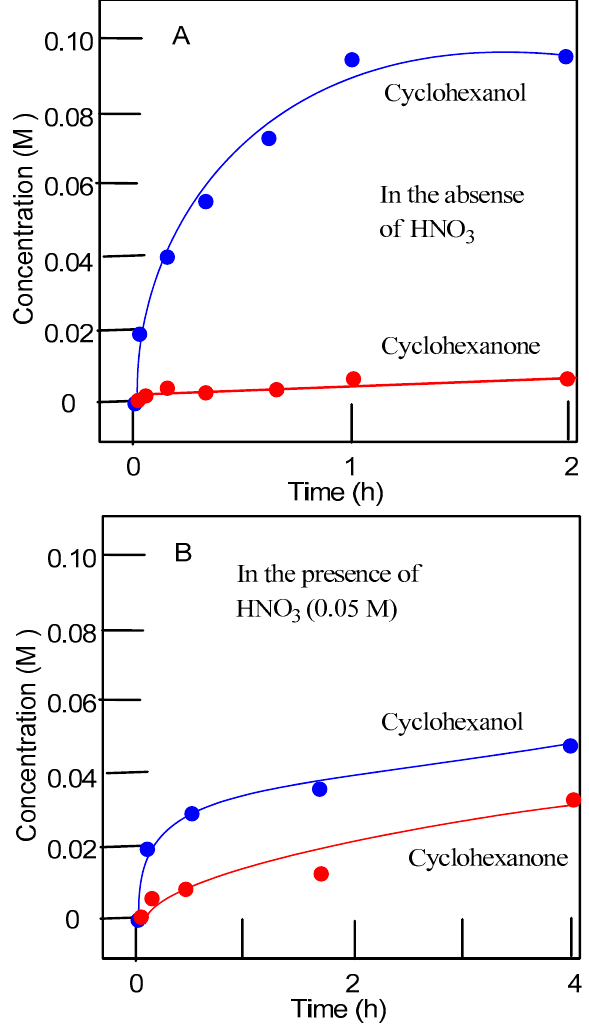
Figure 5. Accumulation of cyclohexanol and cyclohexanone in the oxidation of cyclohexane (0.46 M) with hydrogen peroxide (2.0 M, 50% aqueous) catalyzed by compound 1 (5 × 10 − 4 M) in MeCN at 50 °C. Concentrations of cyclohexanone and cyclohexanol were determined after reduction of the aliquots with solid PPh 3 . Graph A: in the absence of HNO 3. Graph B: in the presense of HNO 3.